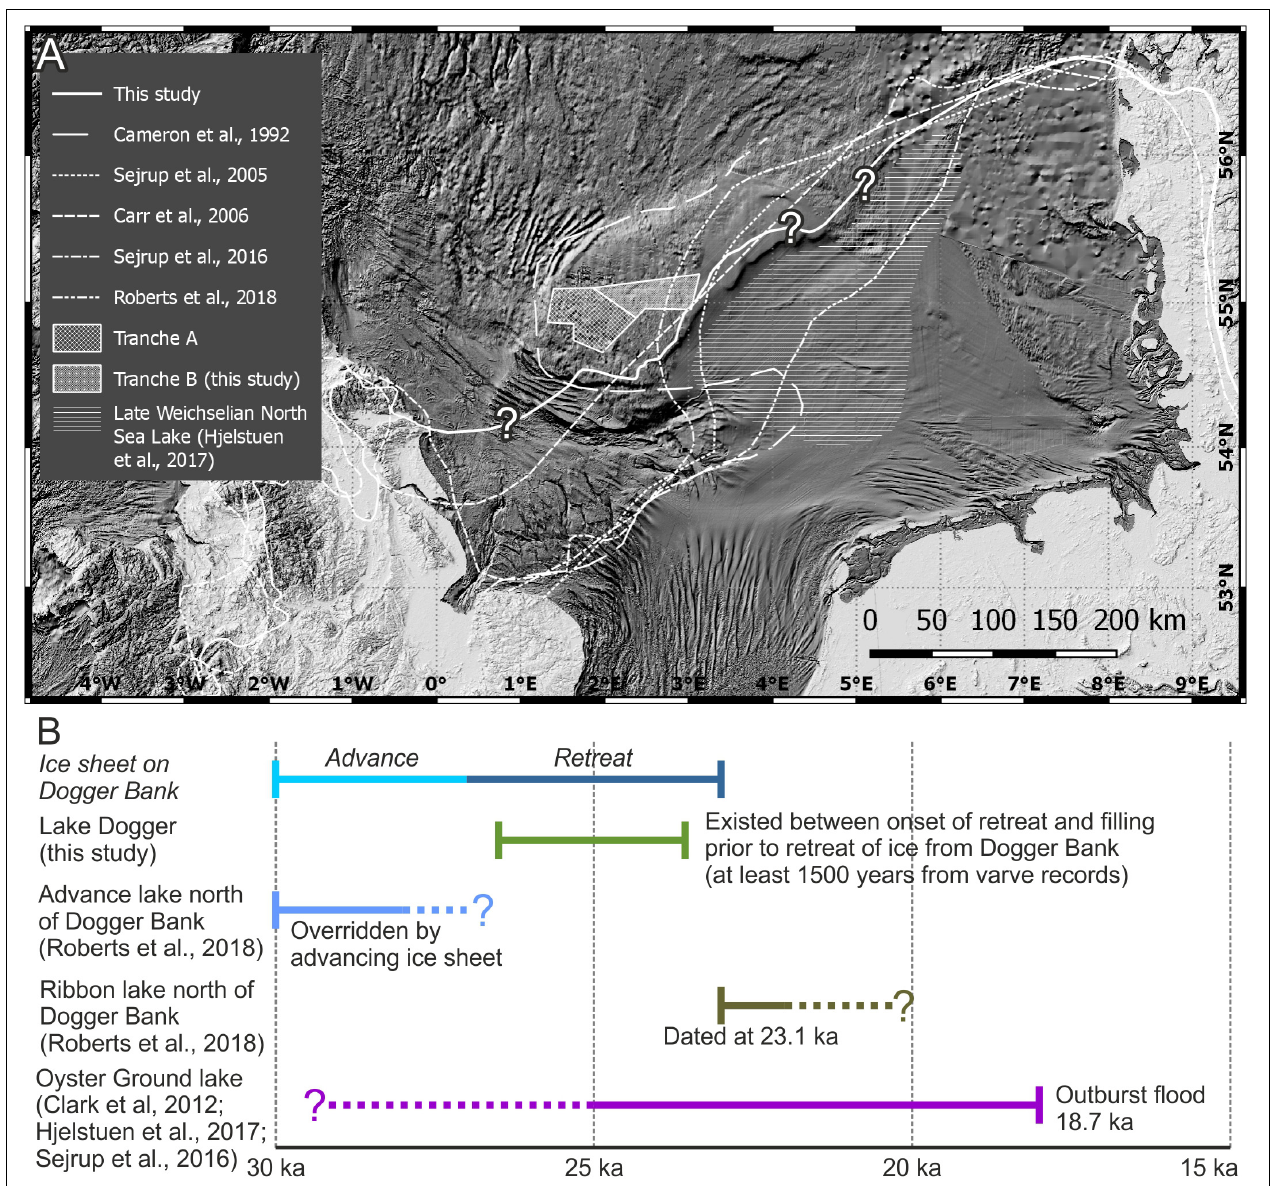
FIGURE 9 | (A) Comparison between previous inferred maximum LGM ice sheet extents (Cameron et al., 1992; Sejrup et al., 2005, 2016; Carr et al., 2006; Roberts et al., 2018) and the new extent proposed in this study. The North Sea Lobe is a later feature of the ice sheet (Dove et al., 2017; Roberts et al., 2018) and has been left off our LGM reconstruction. (B) Timeline of the existence of different proglacial lakes in the North Sea basin during and after the LGM. Compiled from this study Clark et al. (2012), Sejrup et al. (2016), Hjelstuen et al. (2017), and Roberts et al. (2018). Bathymetry data: GEBCO